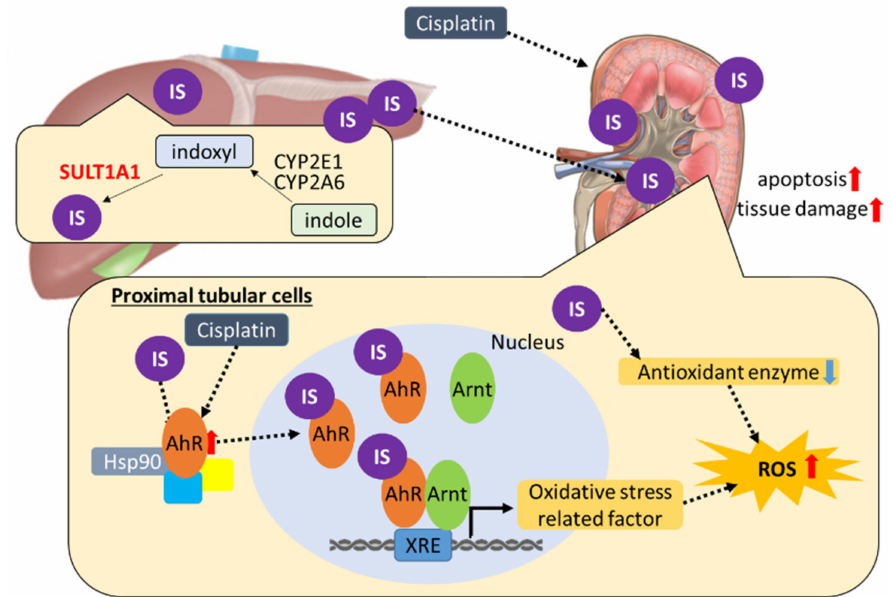
Figure 9. Proposed schematic representation summarizing the toxicological involvement of IS in the pathogenesis mechanism of acute kidney injury induced by cisplatin: with accumulation of serum IS, exposure the kidney to IS increases. In renal tubular cells, cisplatin partially enhances AhR expression. IS interacts as a ligand with a AhR complex composed of heat-shock protein 90 and a 43 kDa protein, triggering a conformational change in AhR to a form exhibiting higher affinity for DNA. The IS– AhR complex translocate to the nucleus and binds specific DNA sequences called XRE (xenobiotics response element) by forming a heterodimer with Arnt, thereby activating gene expression that leads to oxidative stress. IS accumulates in renal tissue and decreases antioxidant enzymes that may be involved in ROS elevation. ROS elevation may result in apoptosis and tissue